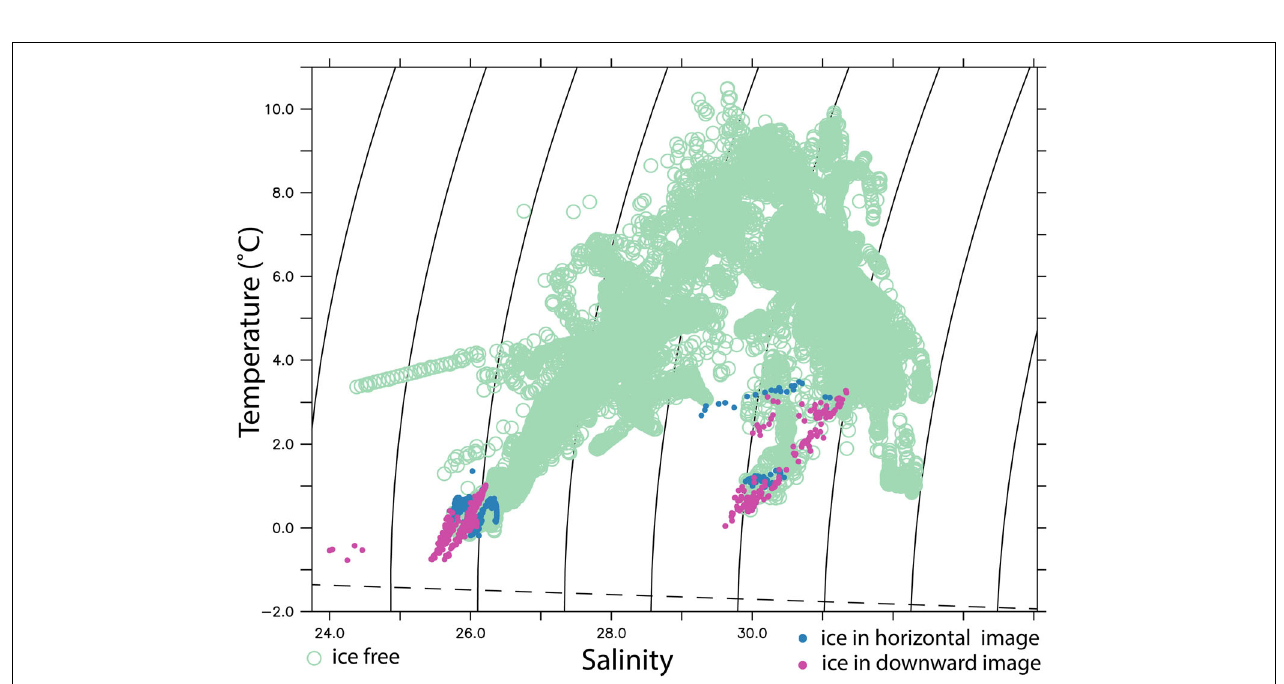
FIGURE 12 | Same as Figure 11 except for seawater temperature and salinity measurements collected by sd-036 during June, July and August of 2019. Light green circles denote times when no ice was visible in the saildrone images; light blue filled dots denote times when ice was visible in the horizontal but not in the downward saildrone photos; magenta dots denote times when ice was visible in the downward-looking saildrone images. Seawater freezing point is shown with a dashed line.